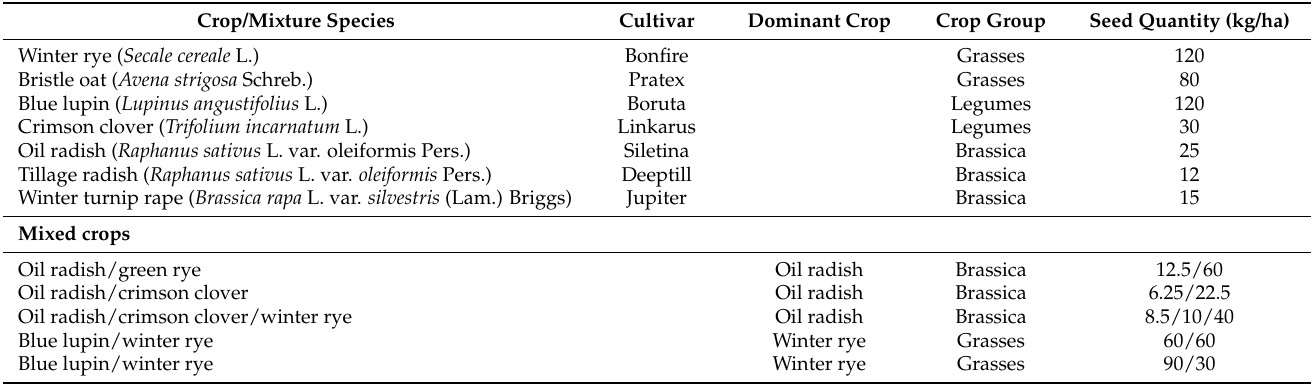
Table 1. Crops and mixtures used in the experiment. Crop group was determined according to crop family for single crops, and crop family of the dominant crop for mixtures. Grasses, Gramineae family; Brassica, Brassicaceae family and Legumes, Leguminosae